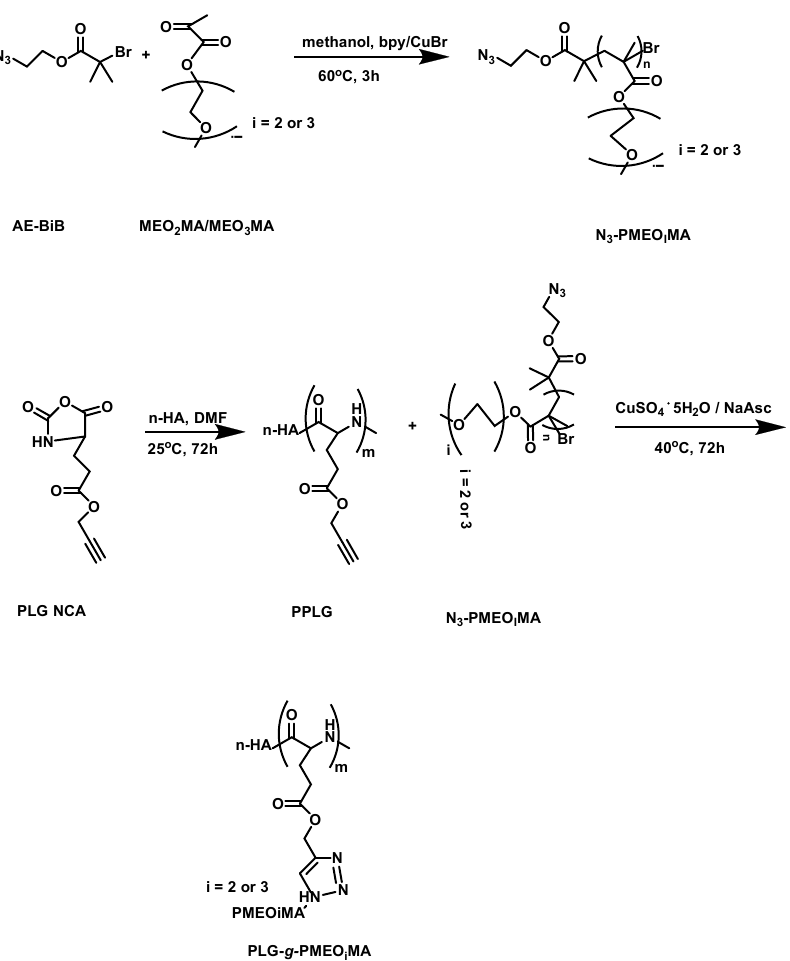
Figure 8. Synthetic route to PLG- g -PMEOiMA.